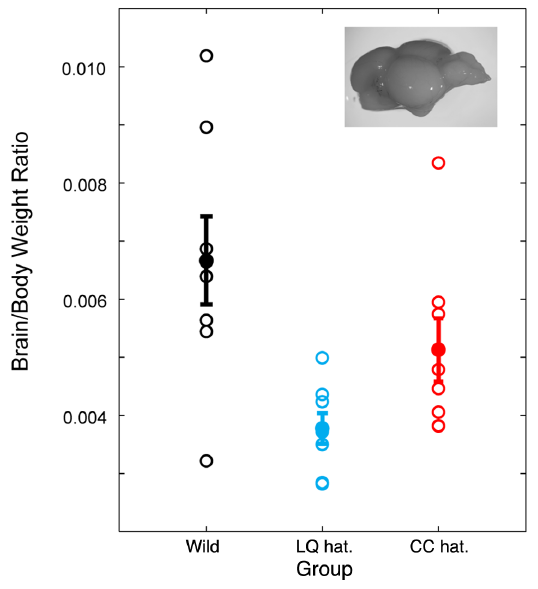
Figure 4. Brain weight differs between groups. Normalized brain weight, expressed as the brain/body weight ratio, of 8 randomly selected individuals (open circles) from each group and means for each group (filled circles, mean 6 1 SEM). The inset shows a brain from a wild-origin juvenile with the olfactory bulbs removed. Scale bar=2 mm.